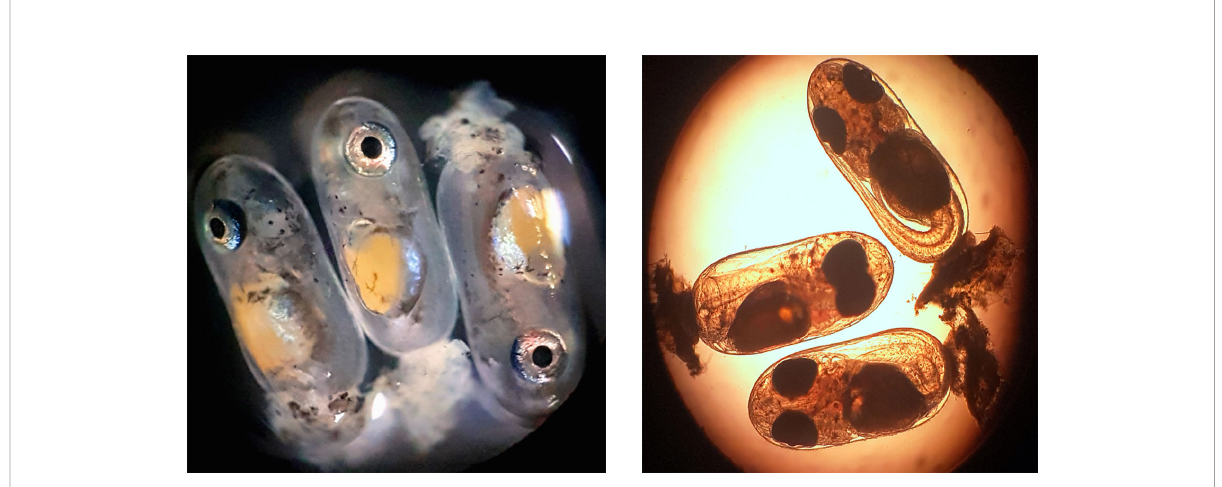
FIGURE 6 Eggs of designer clown fi sh (eighth day) showing embryo